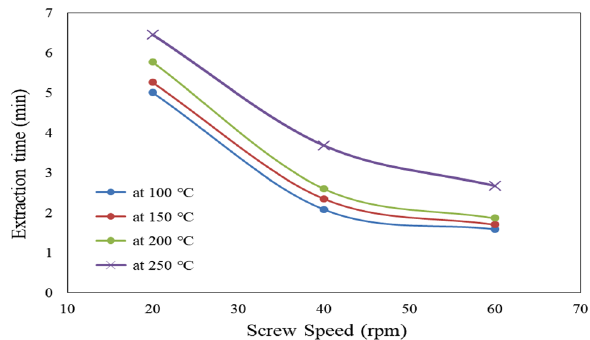
Figure 7. Effect of extraction screw speed and temperature on extraction time.